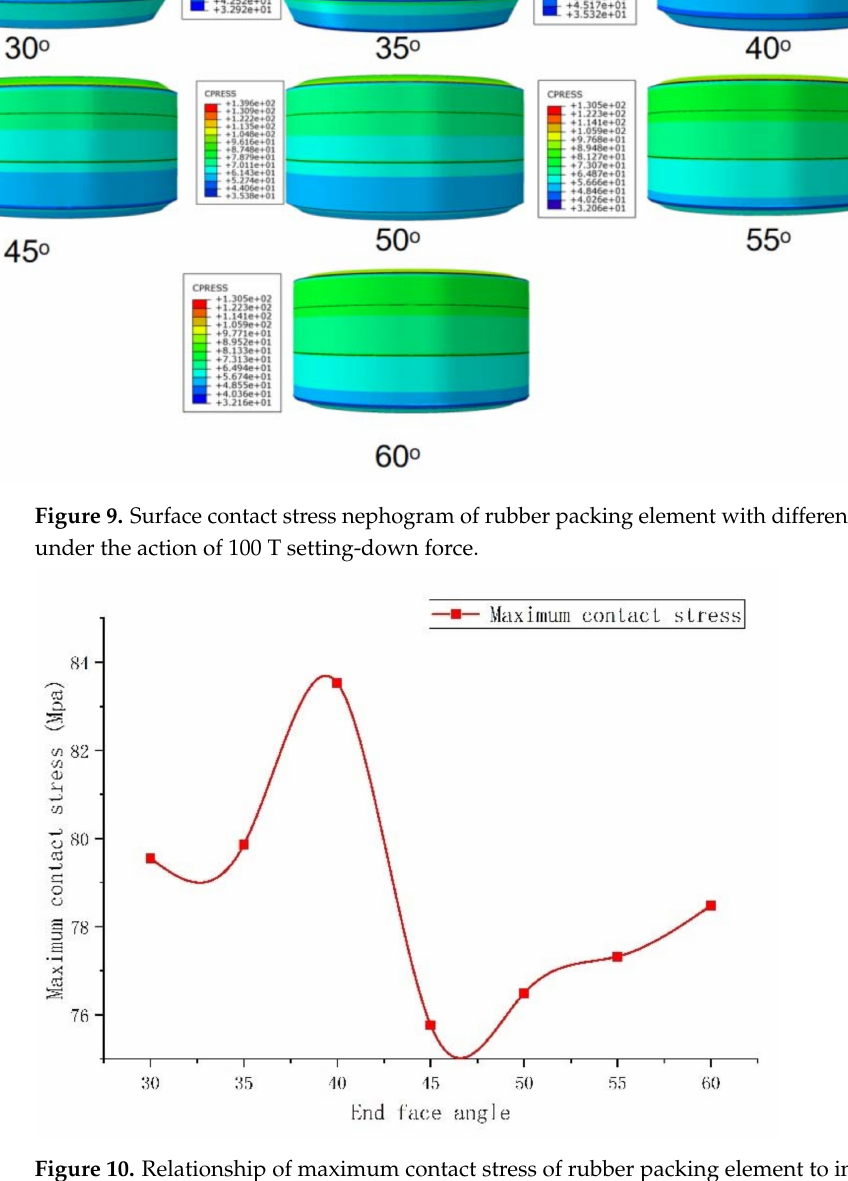
Figure 10. Relationship of maximum contact stress of rubber packing element to inclusion